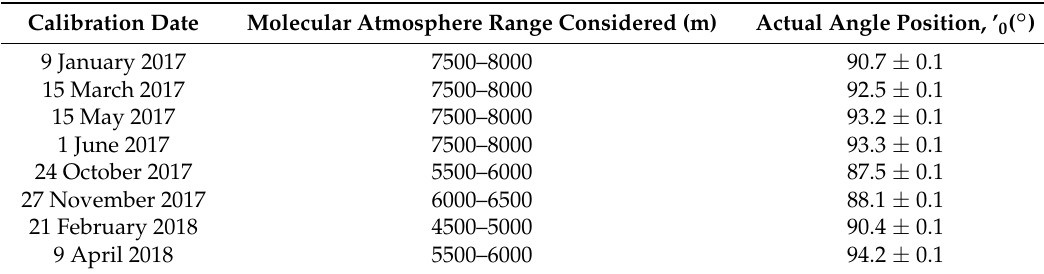
Table 1. Polarizer estimated positions for different calibrations performed during 2017 and